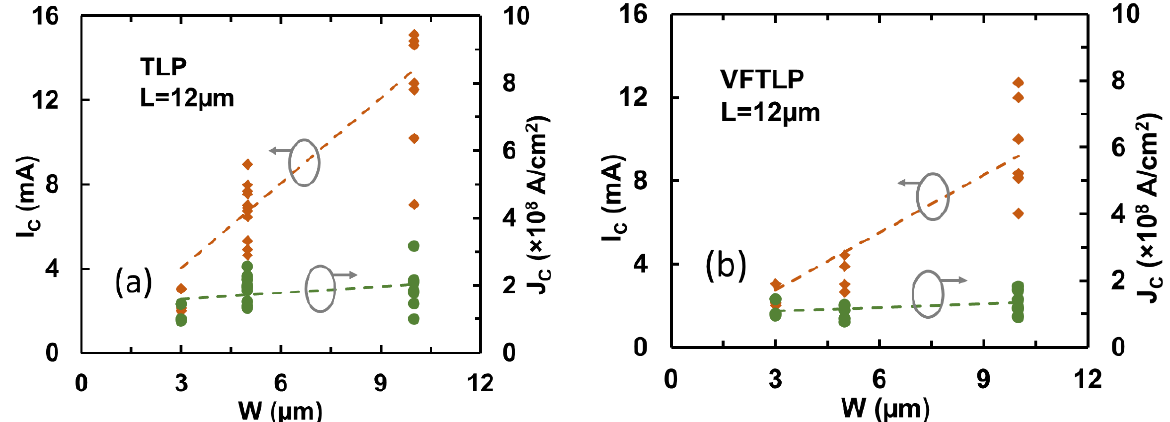
Figure 31. Measured transient ESD I-V characteristics for graphene nanoribbon samples: ( a ) TLP versus VFTLP zapping, and ( b ) TLP I-V curves for GNR wires of different lengths showing impacts on V C [50].